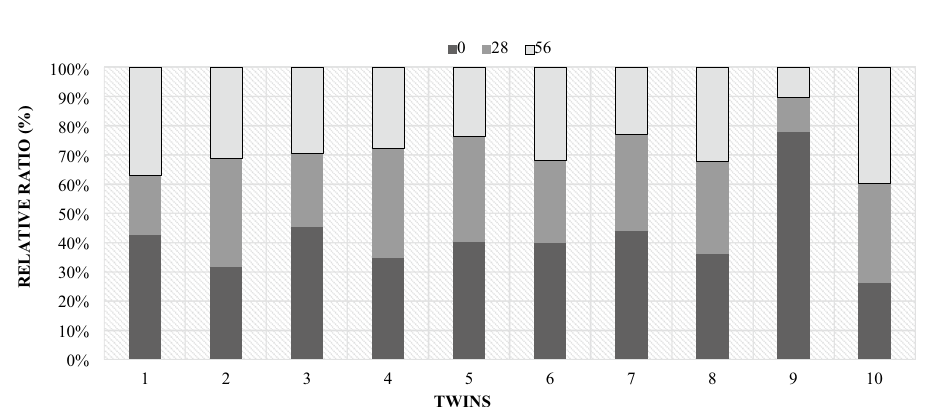
Figure 21. Comparison of the Firmicutes and Bacteroidetes phylum at day 56th postpartum in ewes and their offspring (1—mother, 1 J—twins).